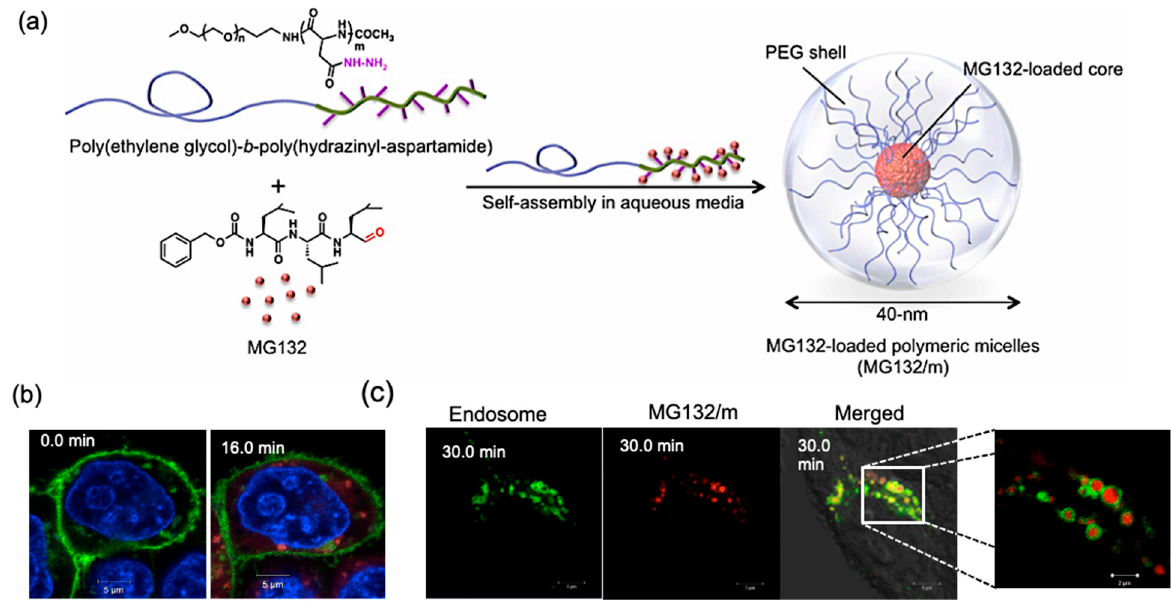
Figure 2. Proteasome inhibitor with MG132-loaded pH-sensitive polymeric micelles. ( a ) Proteasome inhibitor MG132 was conjugated to the hydrazide moieties of PEG- b -poly(hidrazinyl-aspartamide) copolymer, and this polymer subsequently self-assembled in aqueous media to form polymer micelles with size of around 40 nm. ( b ) In vitro CLSM images of dissociation of BODIPY TR-labeled MG132/m (red) in HeLa-luc cells. Cell membrane was tagged with GFP (green), and the nucleus with Hoechst (blue). Absence of colocalization of micelles and cell membrane confirms the disintegration of the micelles only in the intracellular space. ( c ) In vitro CLSM images of the dissociation of BODIPY TR-labeled MG132/m (red) in late-endosomal compartments, which were marked with GFP (green); enlarged section is shown in the flap. Reprinted with permission from [23]. Copyright Elsevier 2014.